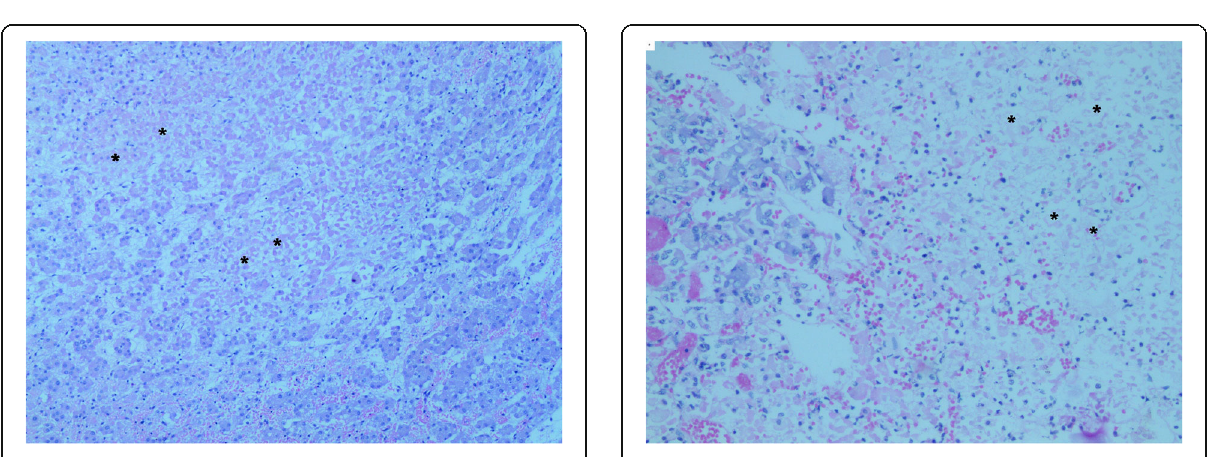
Fig. 6 Section from pituitary asterisk area shows coagulative necrosis/infarction, H&E stain, ×